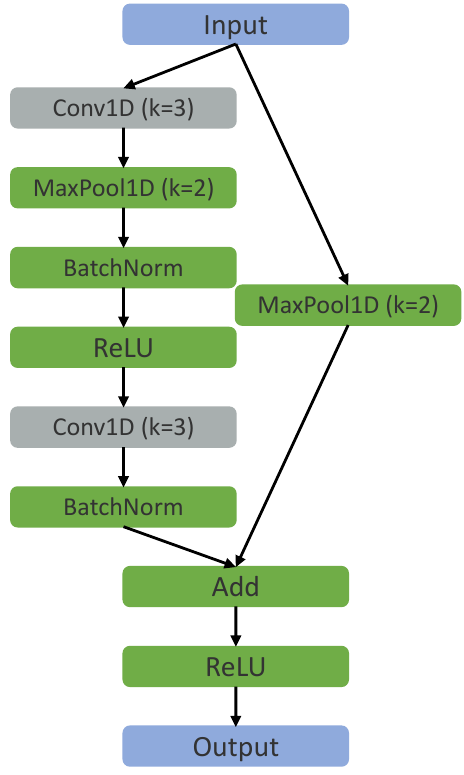
Figure 2. ResNet convolutional block. The letter k stands for “kernel